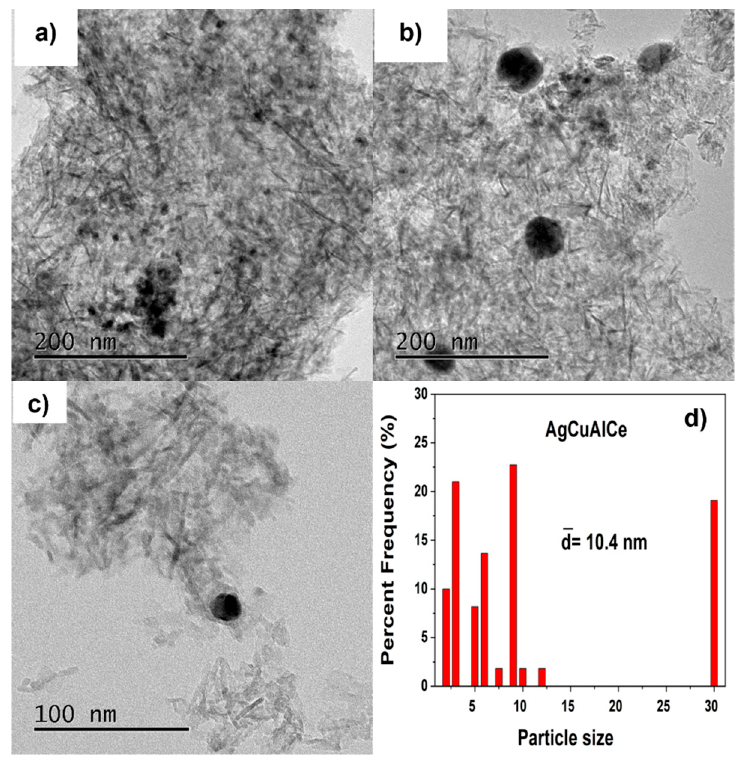
Figure 13. Particle size observed by TEM images of various surface regions at 200 ( a , b ) and 100 ( c ) nm. Statistical distribution ( d ), of fresh bimetallic AgCuAlCe catalyst.